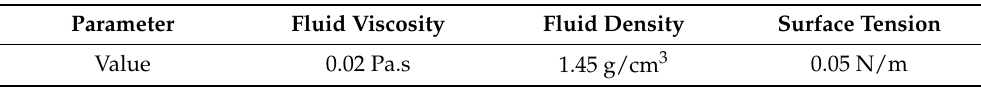
Figure 2. The studied model: ( a ) areas and boundaries of the FE model, and ( b ) FE mesh. The specific parameters of the fluid material used in this study, at 27 ◦ C, are shown in Table 1. The pressure at the inlet was kept constant at 0.05 MPa, and the needle stroke was 0.1 mm, during the whole injection process, without considering heat transfer. Table 1. Fluid material parameters.